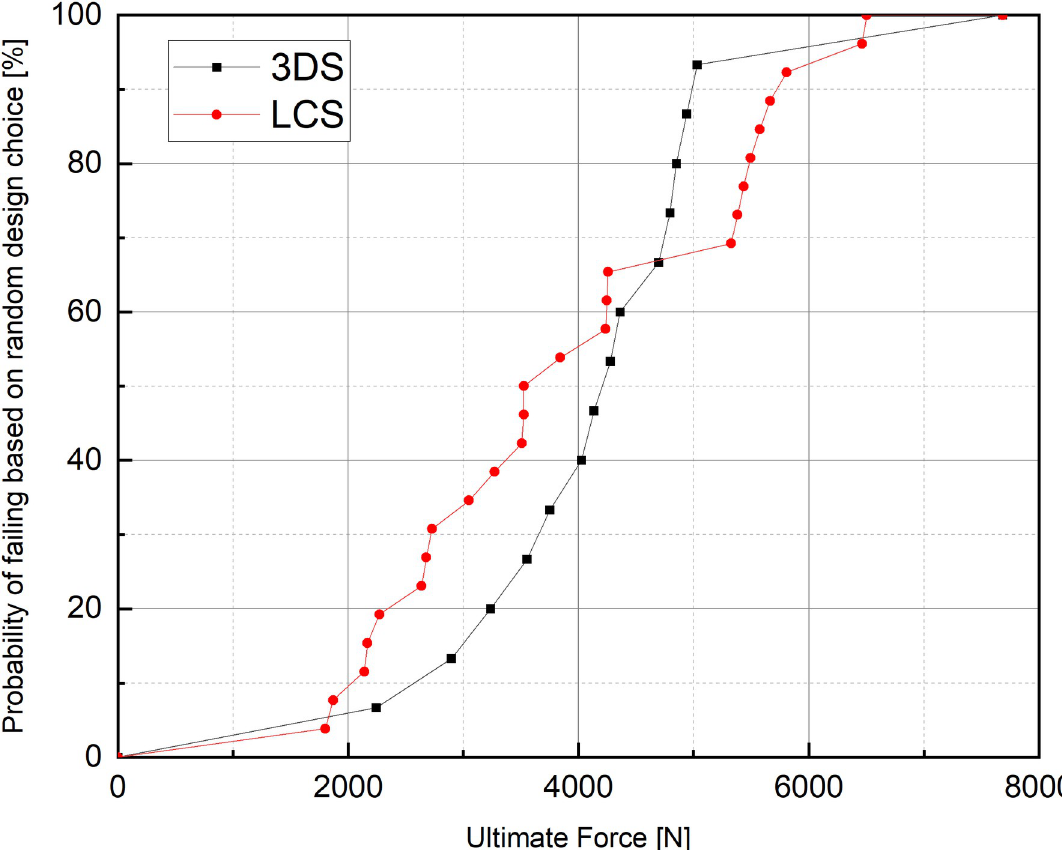
Fig 4. The probability of socket failure. The cumulative distribution function, which shows the probability of socket failure, implicitly accounts for methodological differences that exist between studies. The probability of socket failure for 3DS is similar to LCS except at high